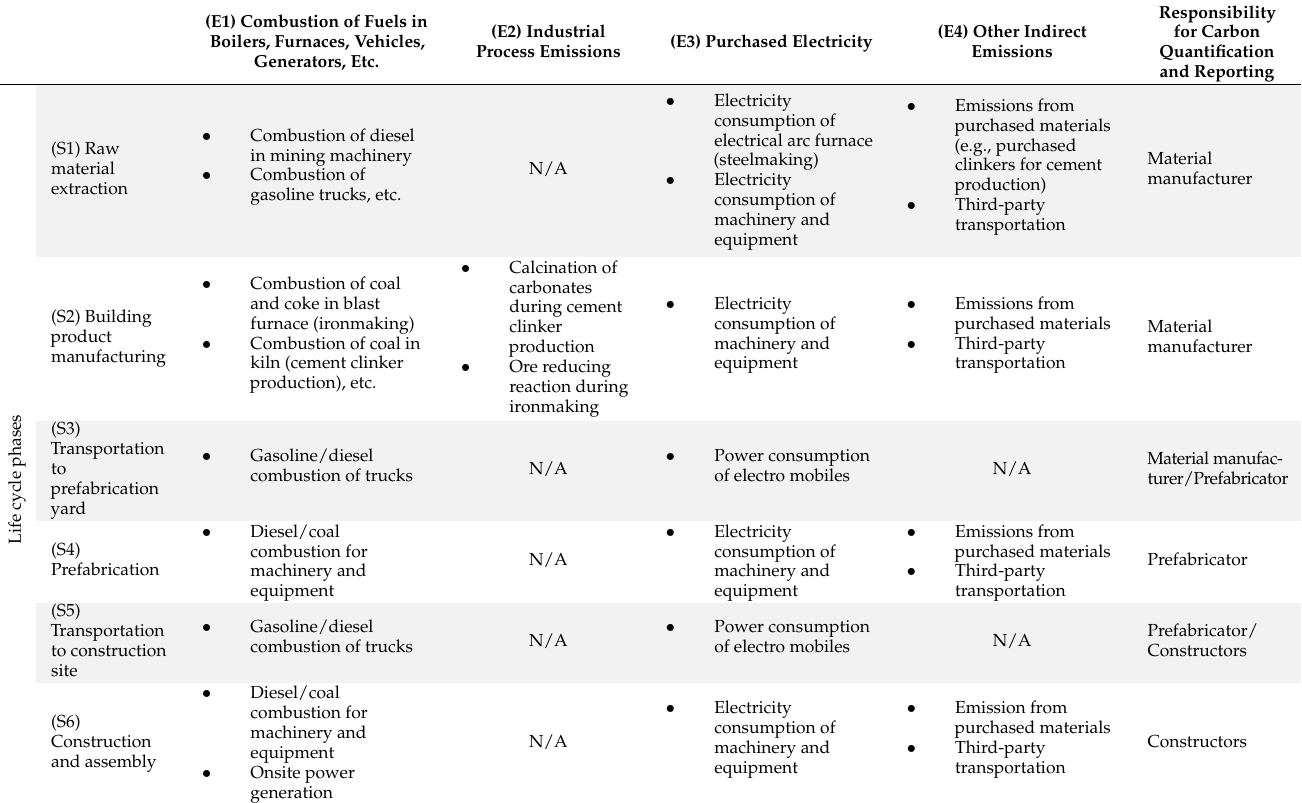
Table 3. Examples of various categories of emission sources in different life cycle